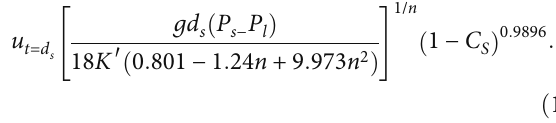
foam quality of constant internal